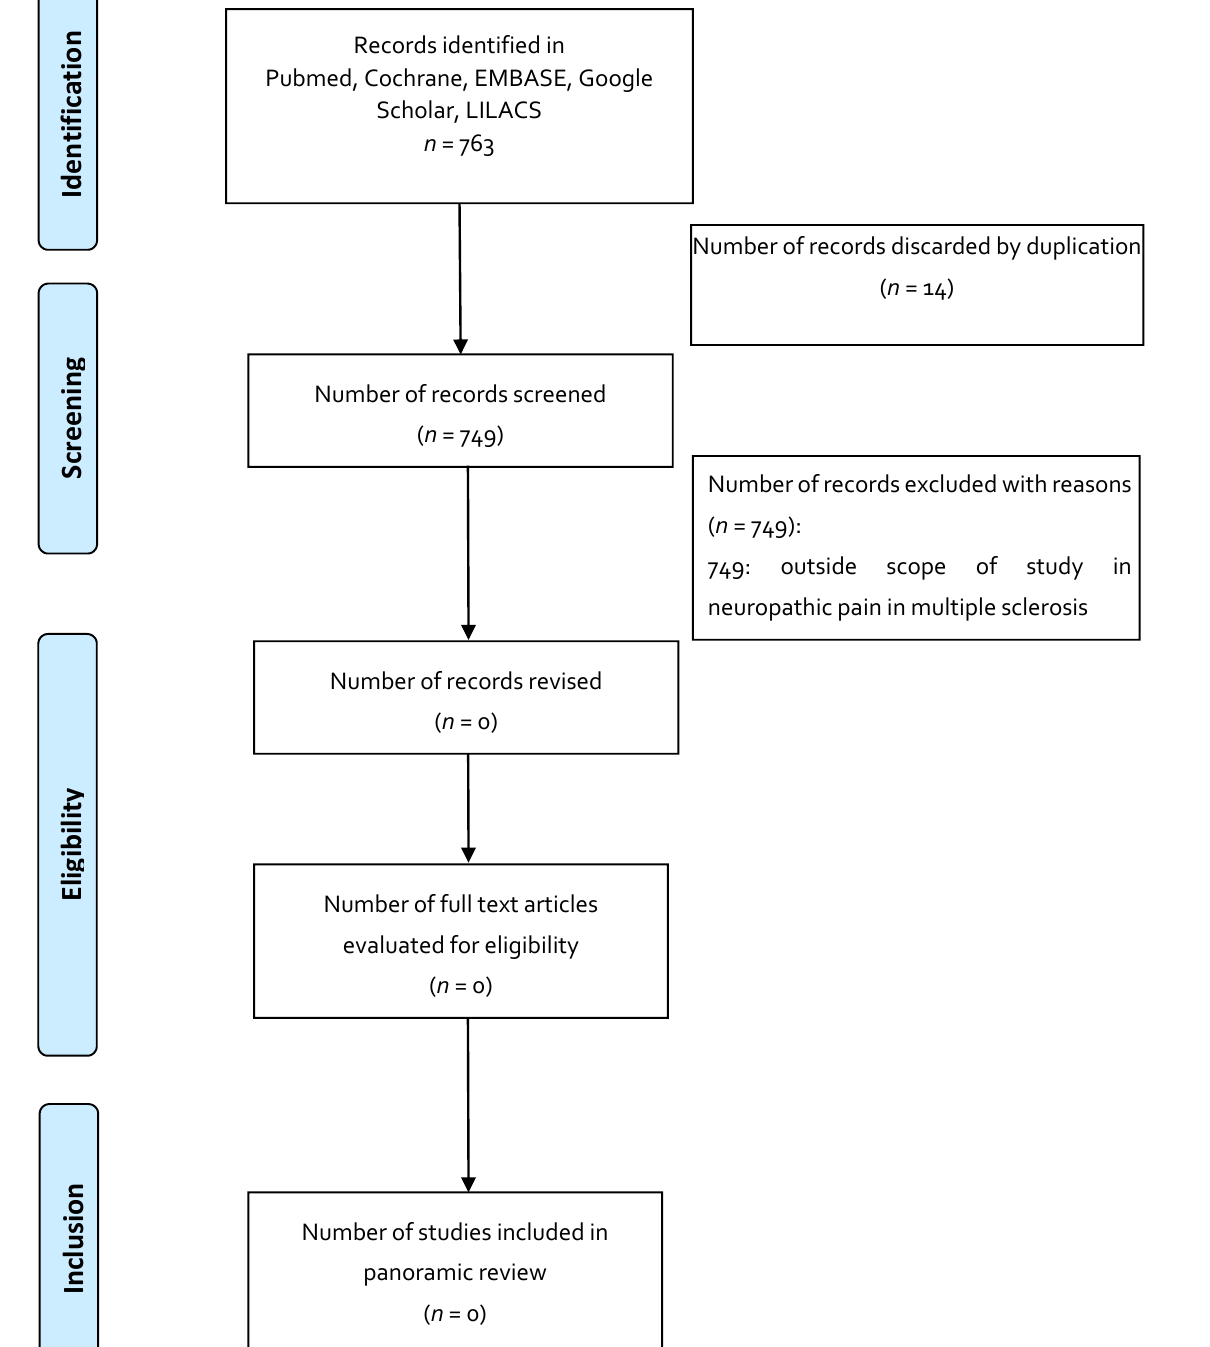
Figure 3. Flowchart depicting the selection process for the studies included in the paper: indication in neuropathic pain in multiple sclerosis.